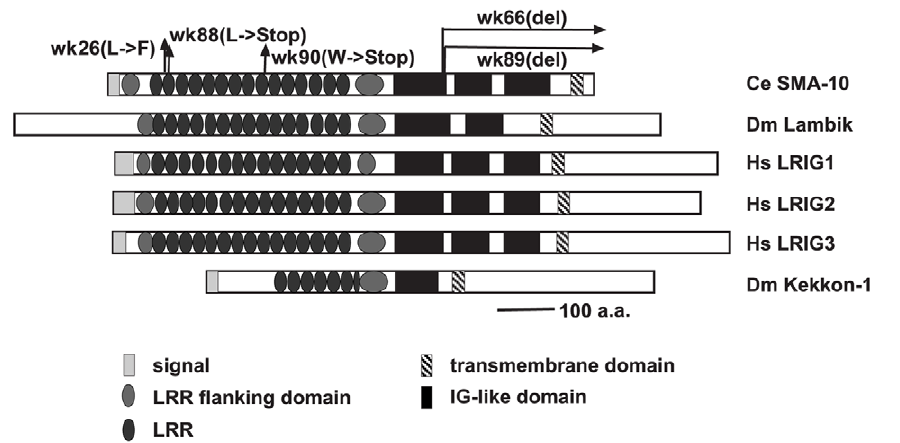
Figure 2. Structural comparison of SMA-10 to Drosophila Lambik and mammalian LRIGs. Schematic diagram of C. elegans SMA-10, Drosphila Lambik, human LRIG1, LRIG2, and LRIG3 and Drosophila Kekkon 1. Domains/motifs are represented as follows: N-terminal signal sequences, light gray rectangles; leucine rich repeat N- and C-terminal domains, medium gray ovals; leucine-rich repeats, dark gray ovals; immunoglobulin-like domains, black boxes; and transmembrane domains, striped rectangles. Arrows above the C. elegans protein sequence indicate mutations affecting the SMA-10 protein. Domains were placed according to SMART analyses [62], Guo et al (LRIGs) [27], and MacLaren et al (Kekkon 1) [63].